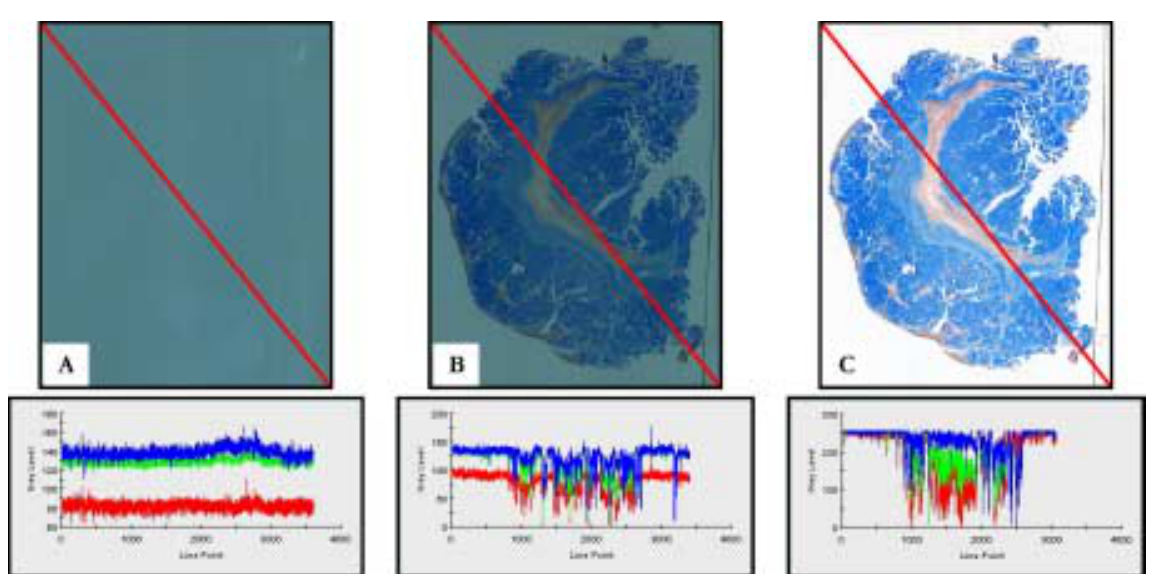
Fig. 3. Image uniformity. Images of the slide holder filter (A), of a whole histological section before (B) and after background correction (C), and their corresponding profile along the red line. This figure can be viewed on http://www.esacp.org/acp/2003/25-2/kim.htm. (ii) Highlighting blood vessels in brown (DAB as a chromogen) and in red (AEC as a chro-